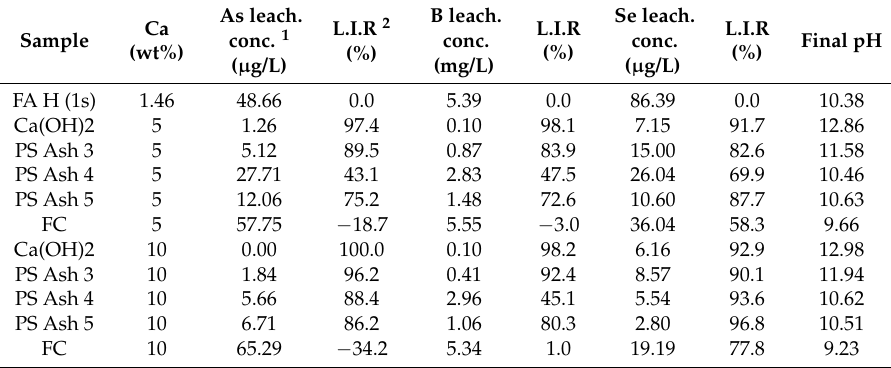
Table 2. Trace element leaching suppression effect of